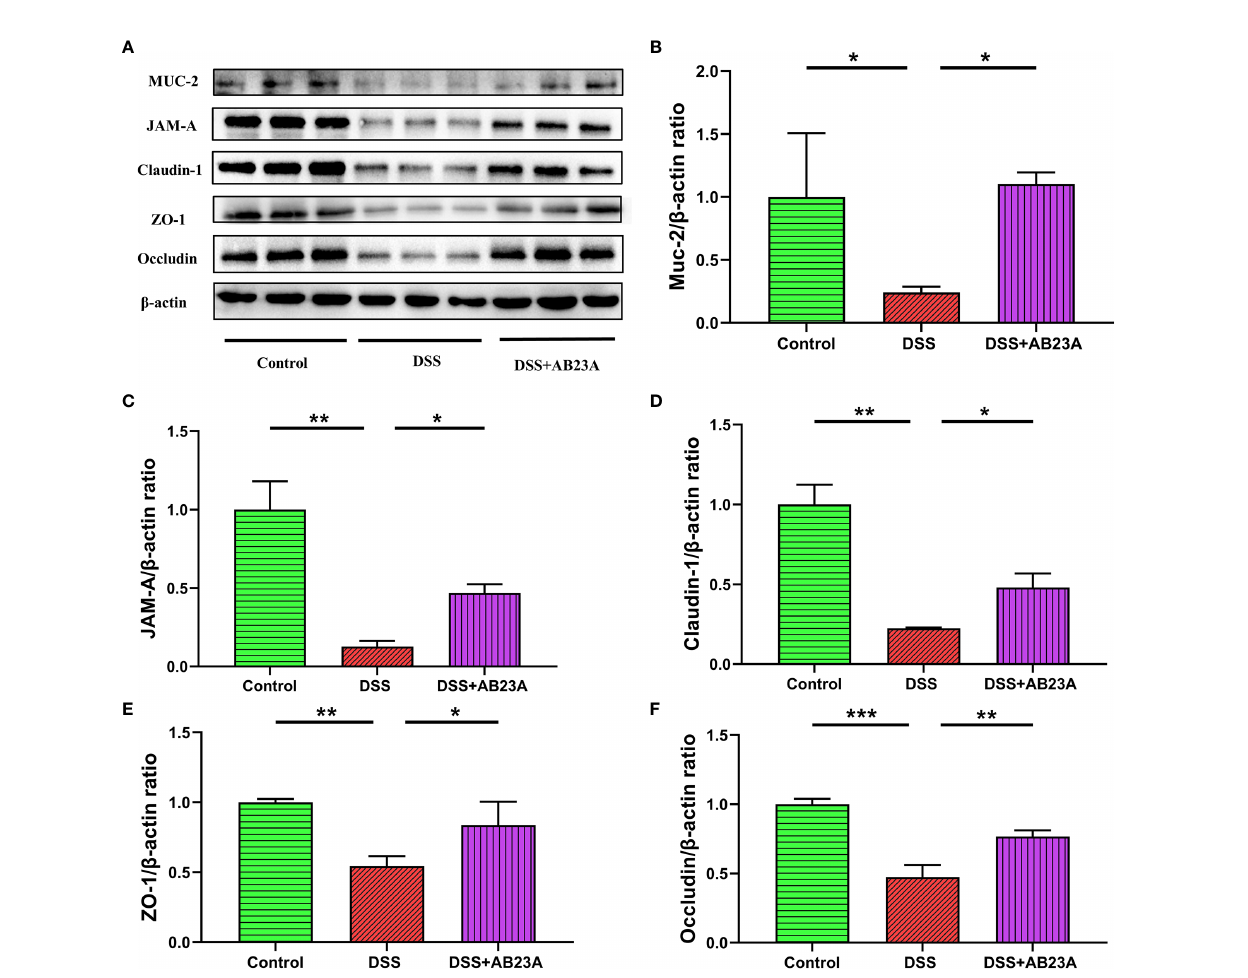
FIGURE 7 | Effect of AB23A treatment on intestinal barrier functions. (A) Immunoblotting of mucin-2, JAM-A, claudin-1, ZO-1, and occludin. (B – F) Mucin-2, JAM-A, claudin-1, ZO-1, and occludin protein expression relative to b -actin. Data are expressed as mean ± SD (n = 3). Di ff erences were analyzed by one-way ANOVA followed by Tukey ’ s post hoc test (*P < 0.05, **P < 0.01, ***P <